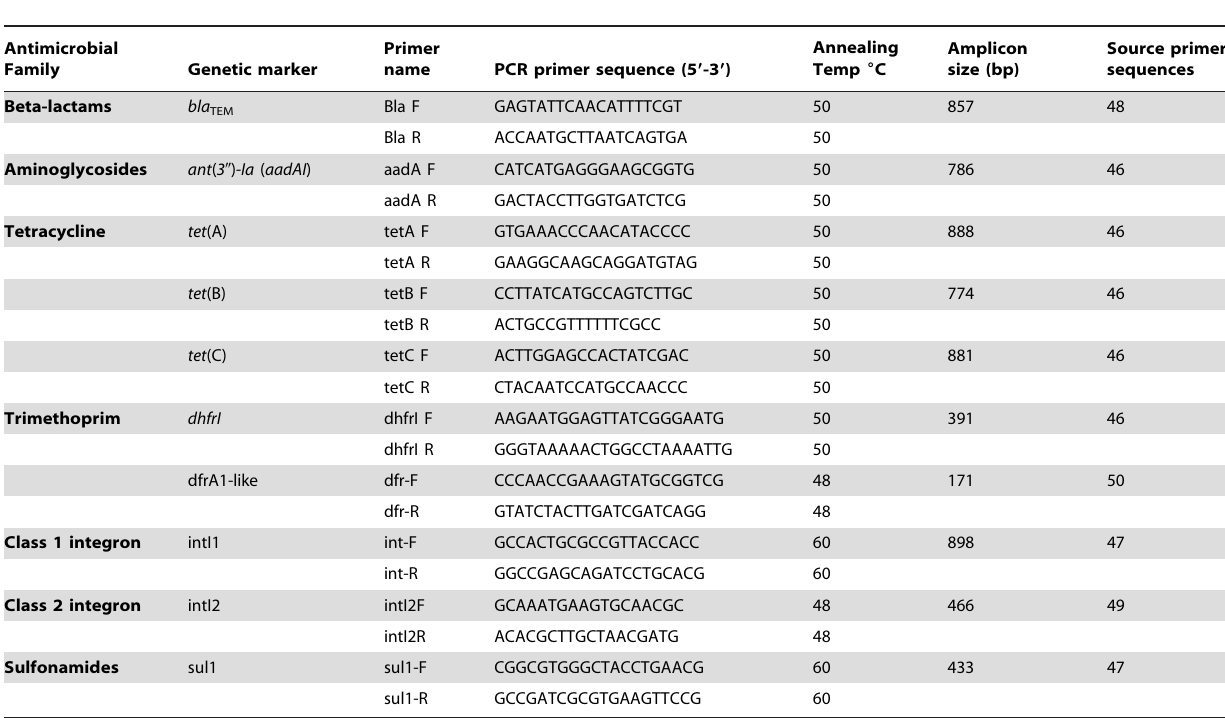
Table 2. Antimicrobial families, genetic markers, and primer sequences, for resistance genes tested.